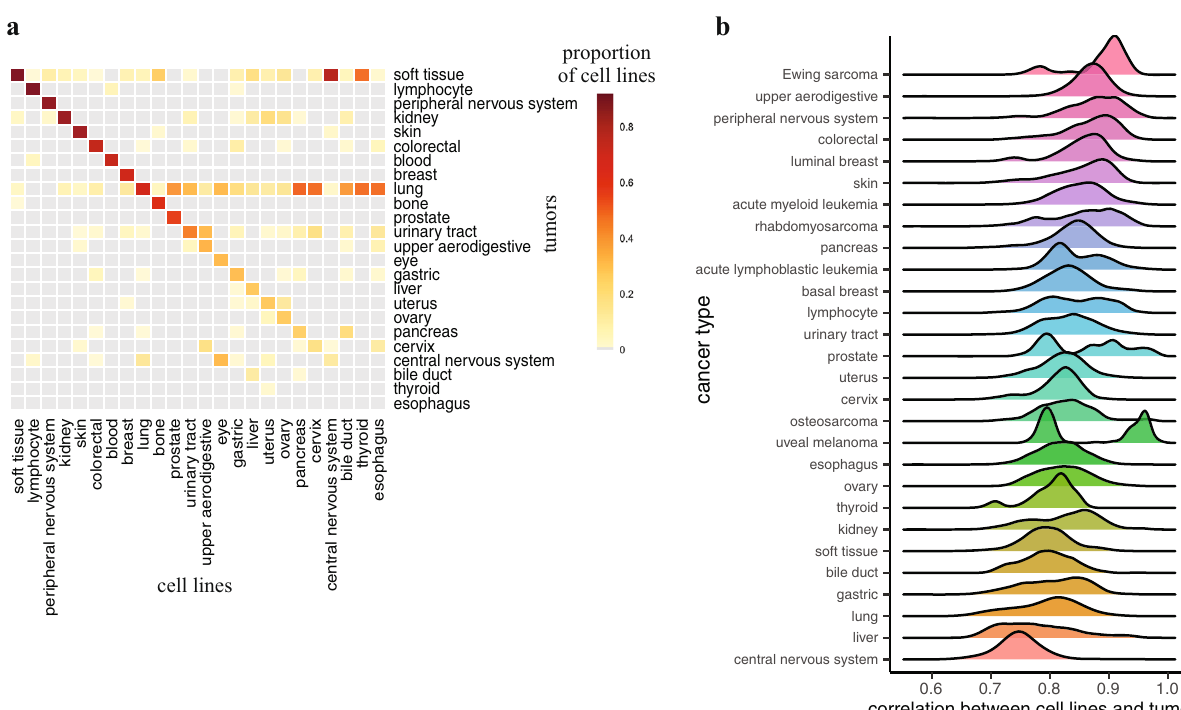
Fig. 3 Classi fi cation of cell lines by tumor type. a The proportion of cell lines ( n = 1,150) that are classi fi ed as each tumor type using